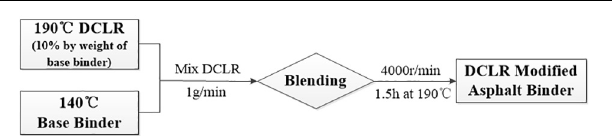
FIGURE 1 | The preparation process of the DCLR modified asphalt